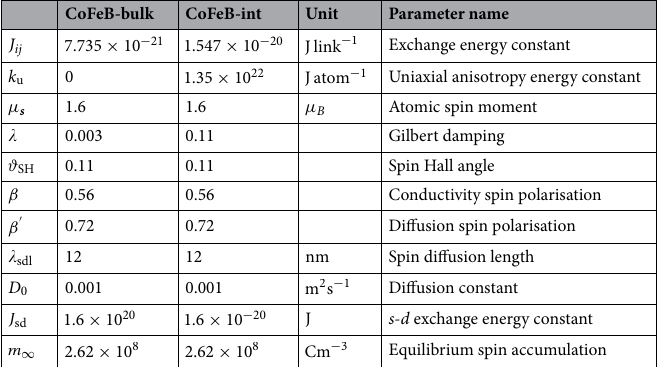
Table 1. List of parameters used in the simulations.